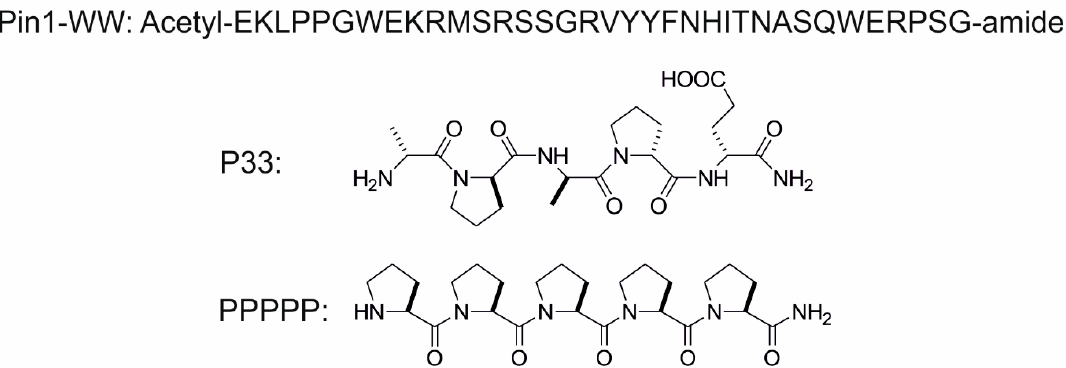
Figure 2. Sequences of the WW domains (Fe65-WW domain, Pin1-WW domain), and chemical structures of P33 and PPPPP.